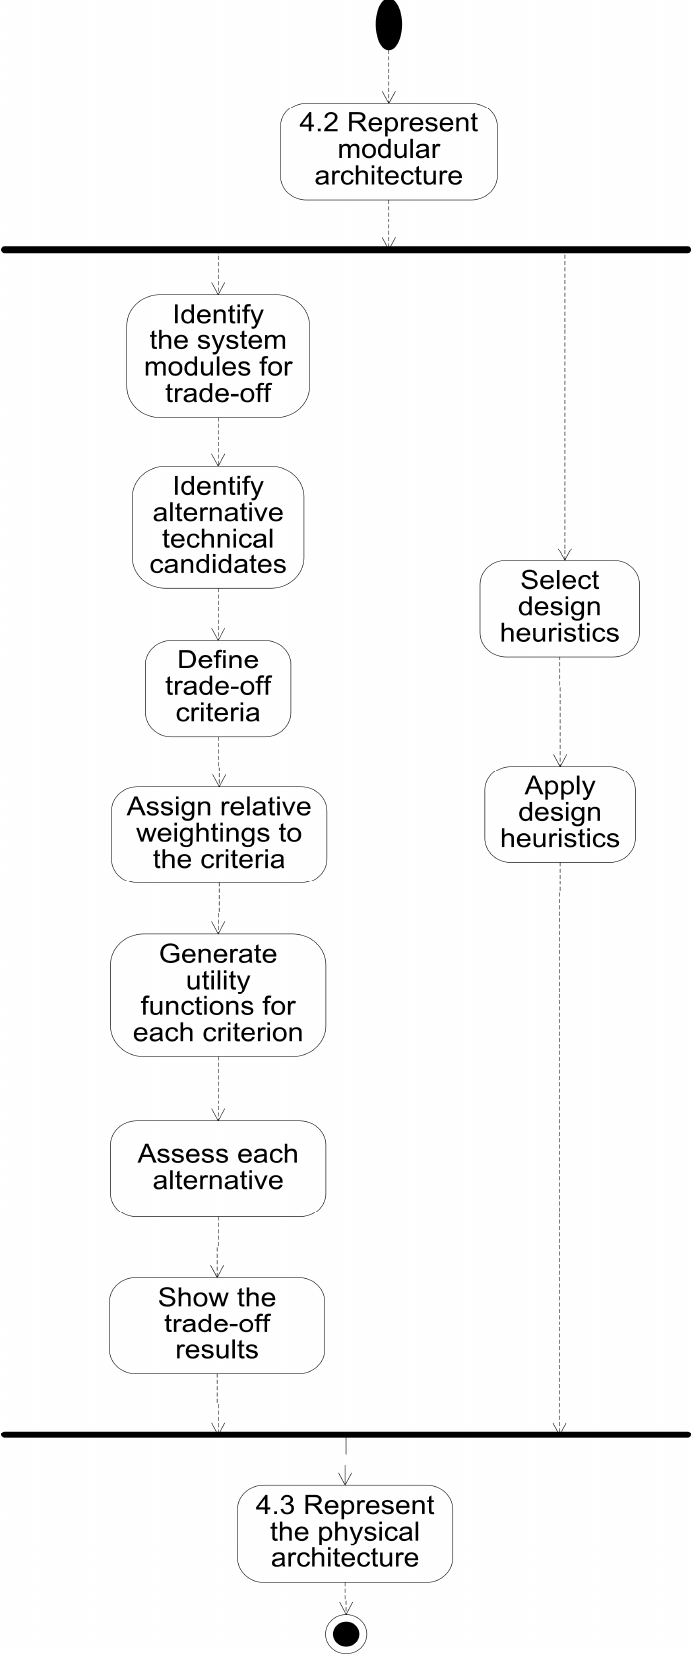
Figure 1. Trade-off and heuristics subprocess for obtaining the refined physical architecture.